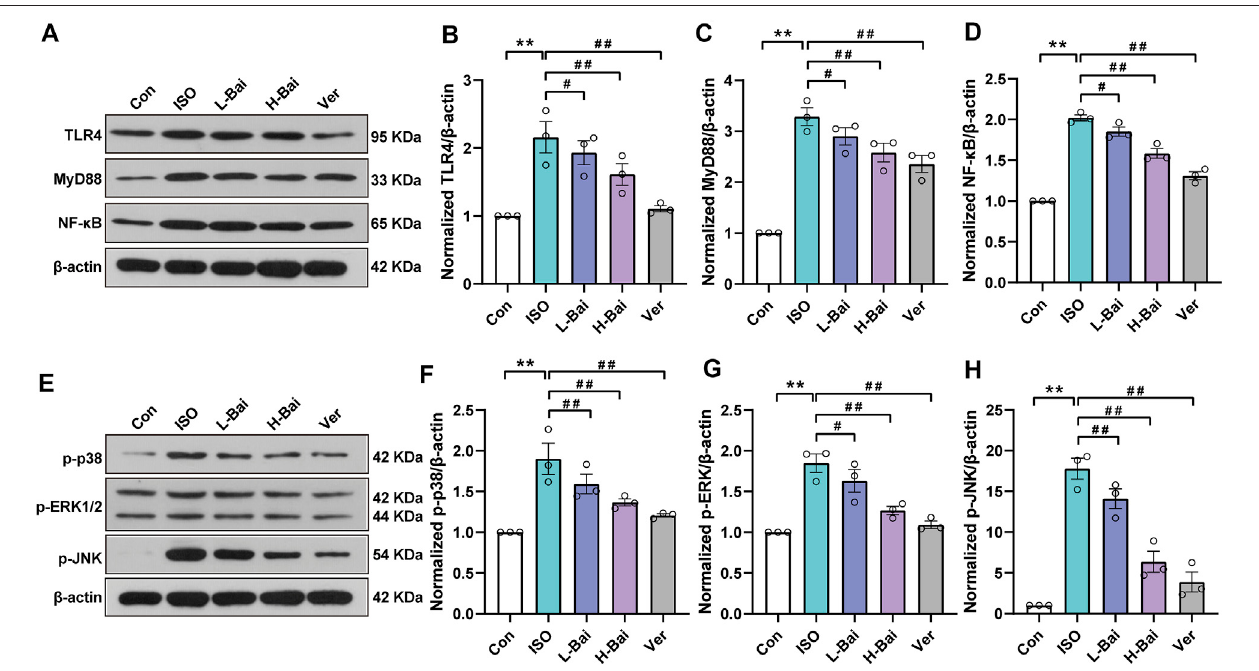
FIGURE 6 | Effects of Bai on TLR4, MyD88, NF- κ B, and MAPKs pathways. (A,E) Western blot was applied to measure the protein expressions of TLR4, MyD88, NF- κ B, p-p38, p -ERK1/2, and p -JNK in mice. (B-D) Relative intensities of TLR4, MyD88, and NF- κ B were normalized to β -actin (F – H) in addition to p-p38, p-extracellular-regulatedkinase1/2 ( p -ERK1/2),and p -junkinase( p -JNK).Valuesarepresented asmeans±S.E.M. p < 0.01versusCon; p < 0.01, p < 0.05versusISO.